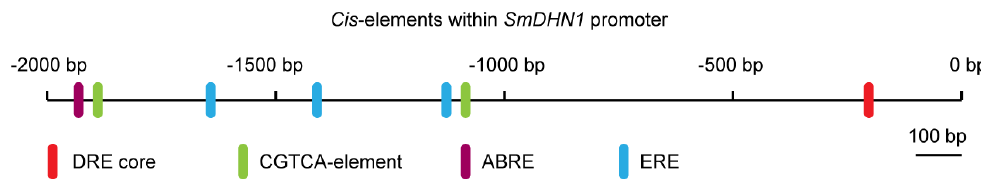
Figure 9. Diagram of cis − elements within the SmDHN1